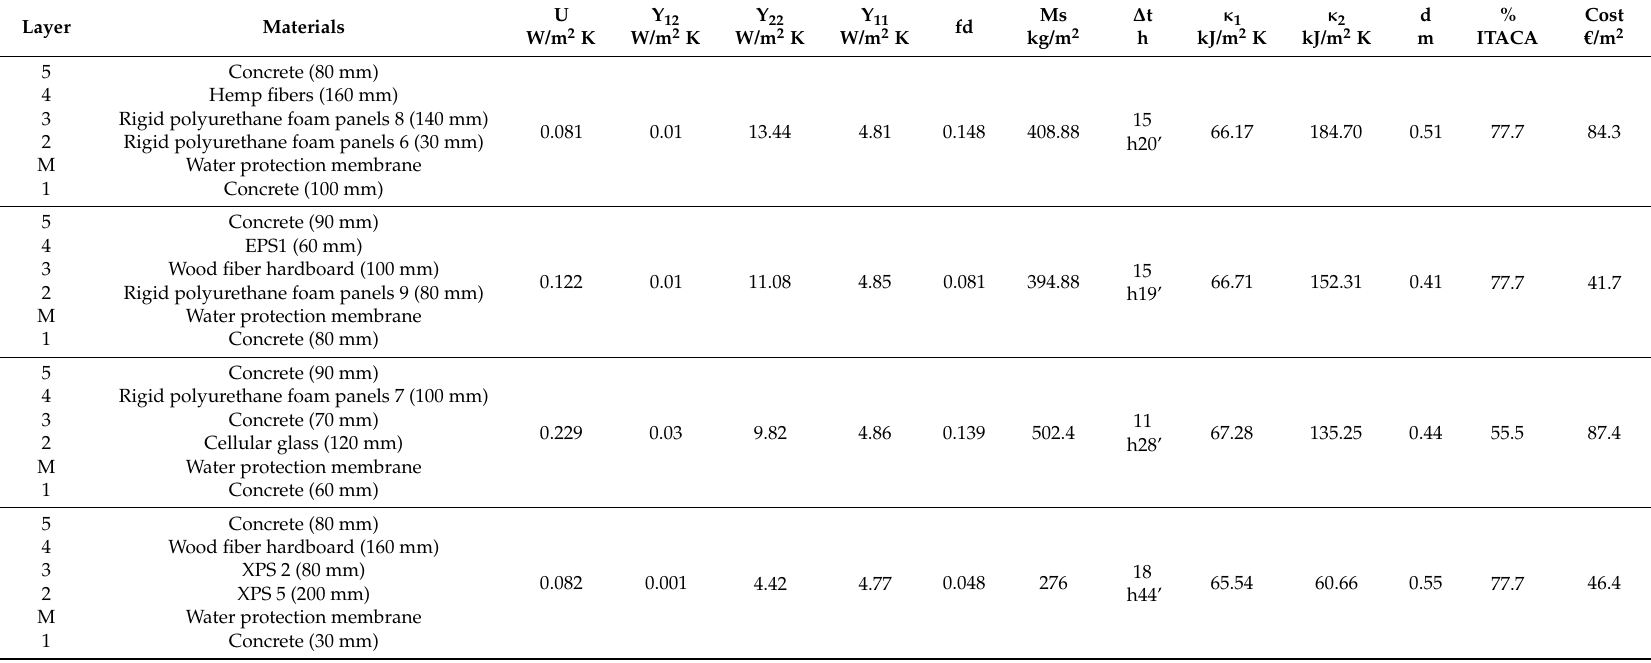
Table 8. Example of high performance slab-on-ground floor with no constraints imposed in the